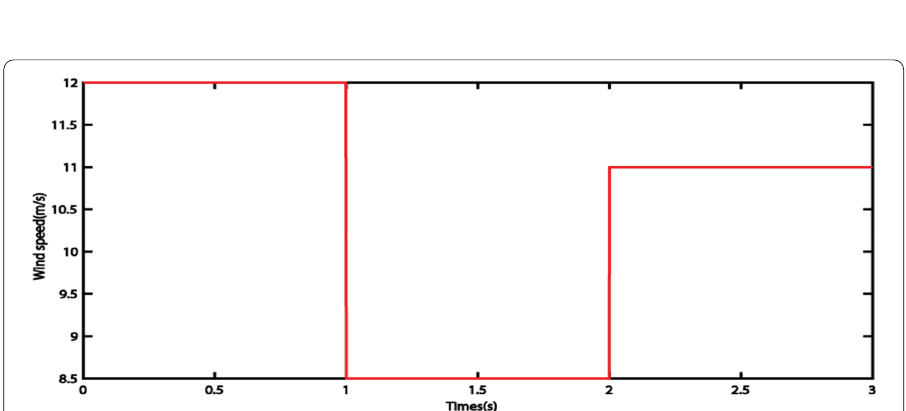
Fig. 13 Wind speed scenario with (m/s)